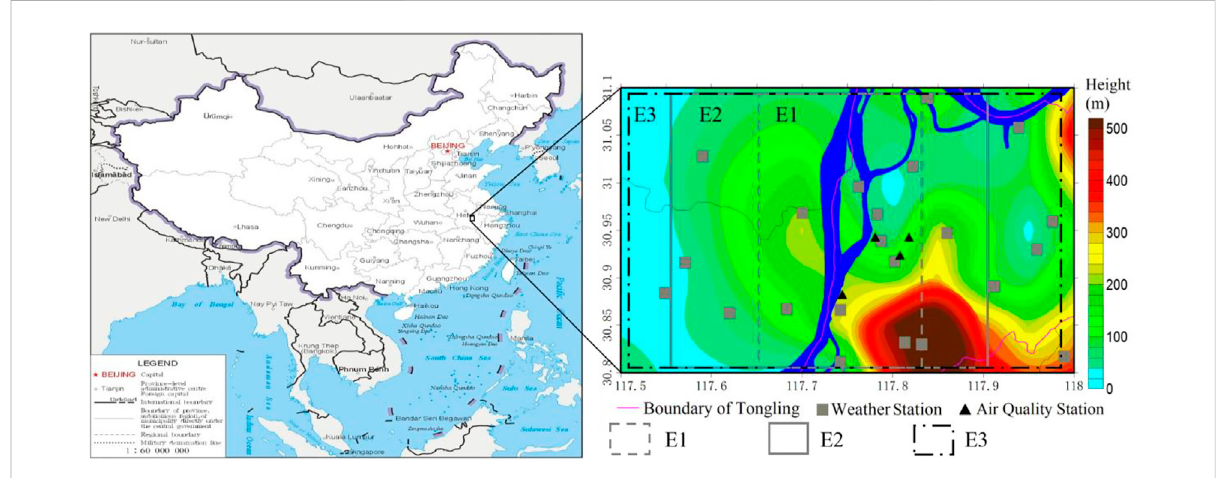
FIGURE 1 Map of the study region (squares are weather stations, and triangles are air quality stations, color shadow is altitude, blue is Yangtze River).